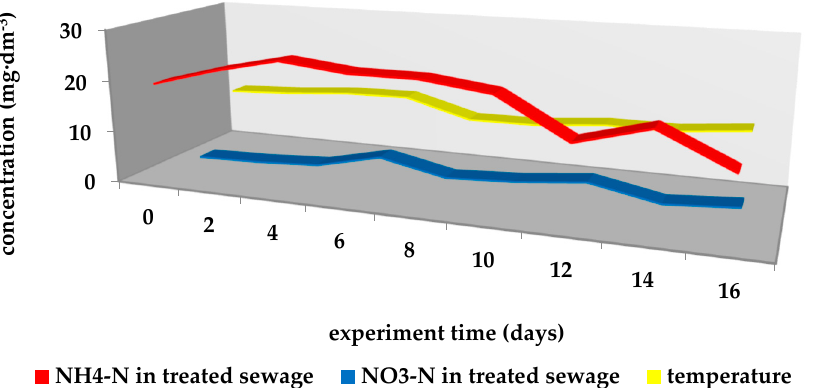
Figure 8. The efficiency of the nitrification process in the biological wastewater treatment system in the control chamber.